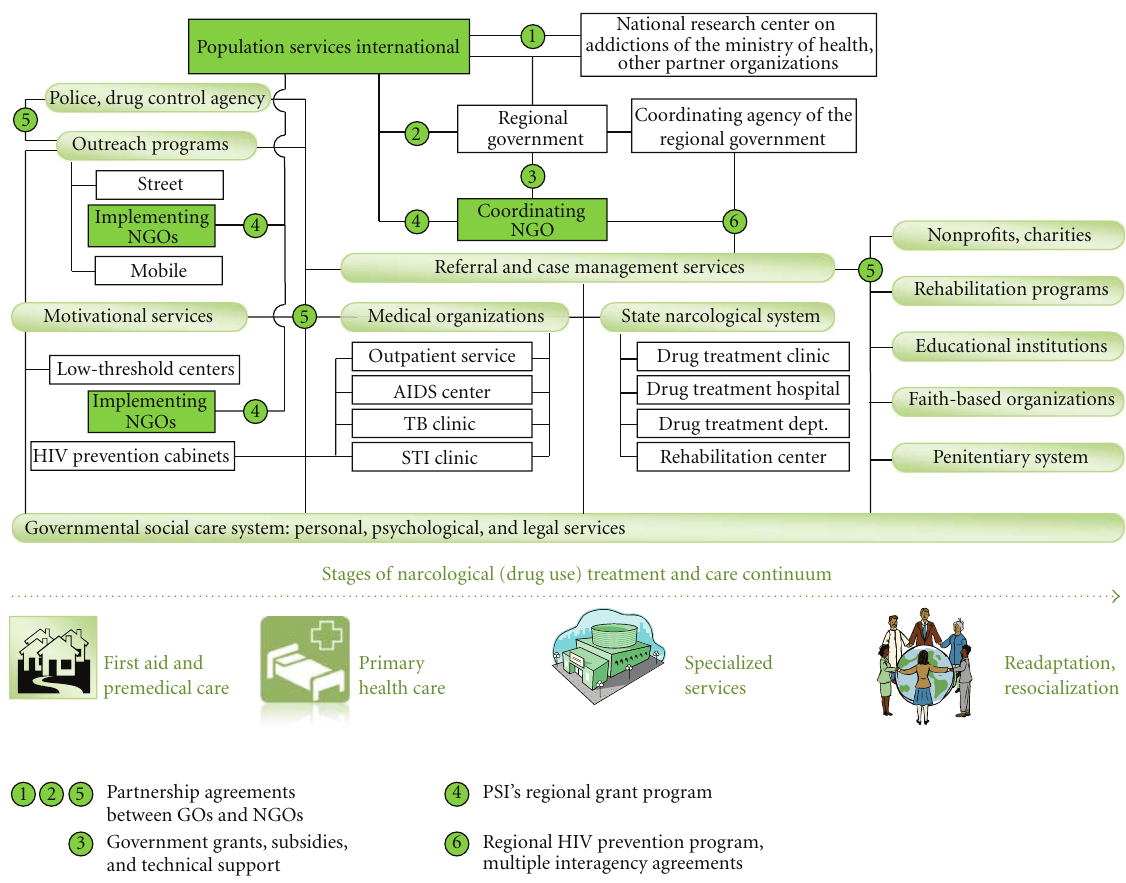
Figure 1: Implementation of the RPS-IDU Model at the regional